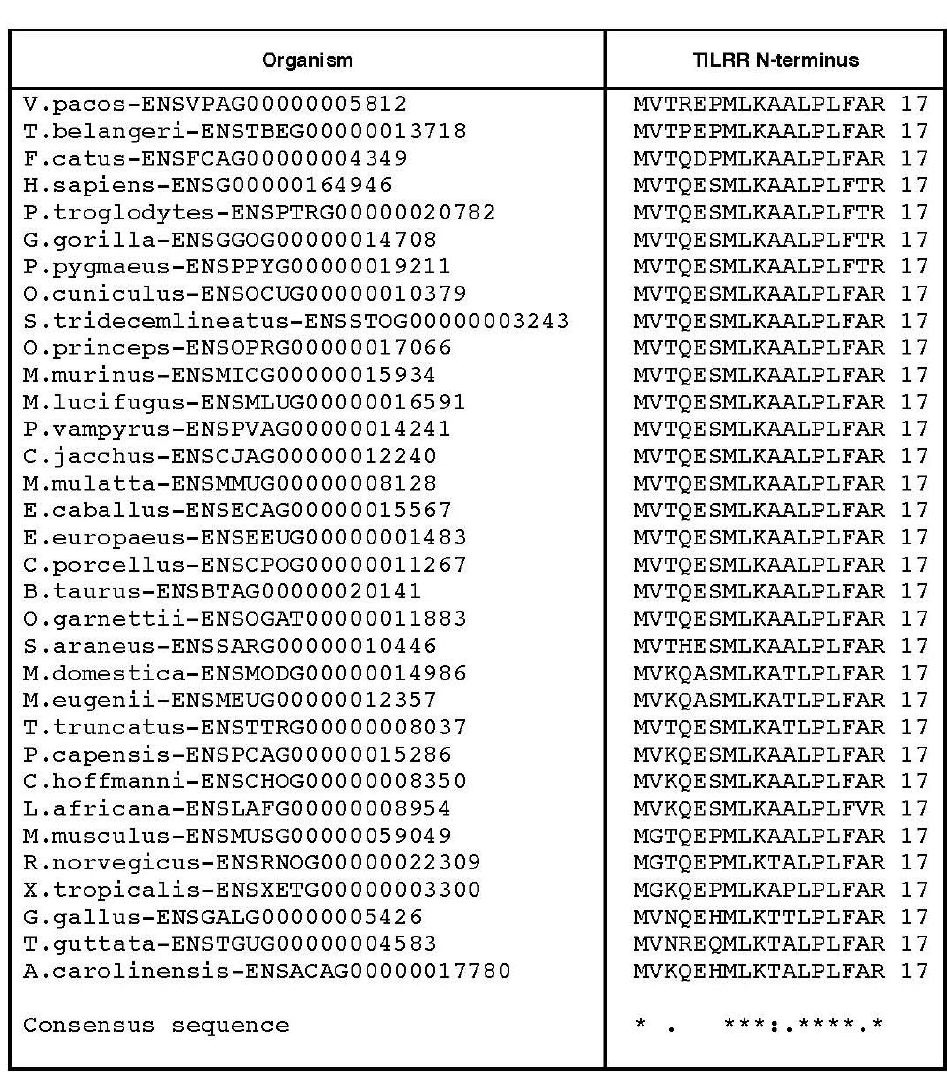
Figure 2. Comparison of TILRR N -terminal